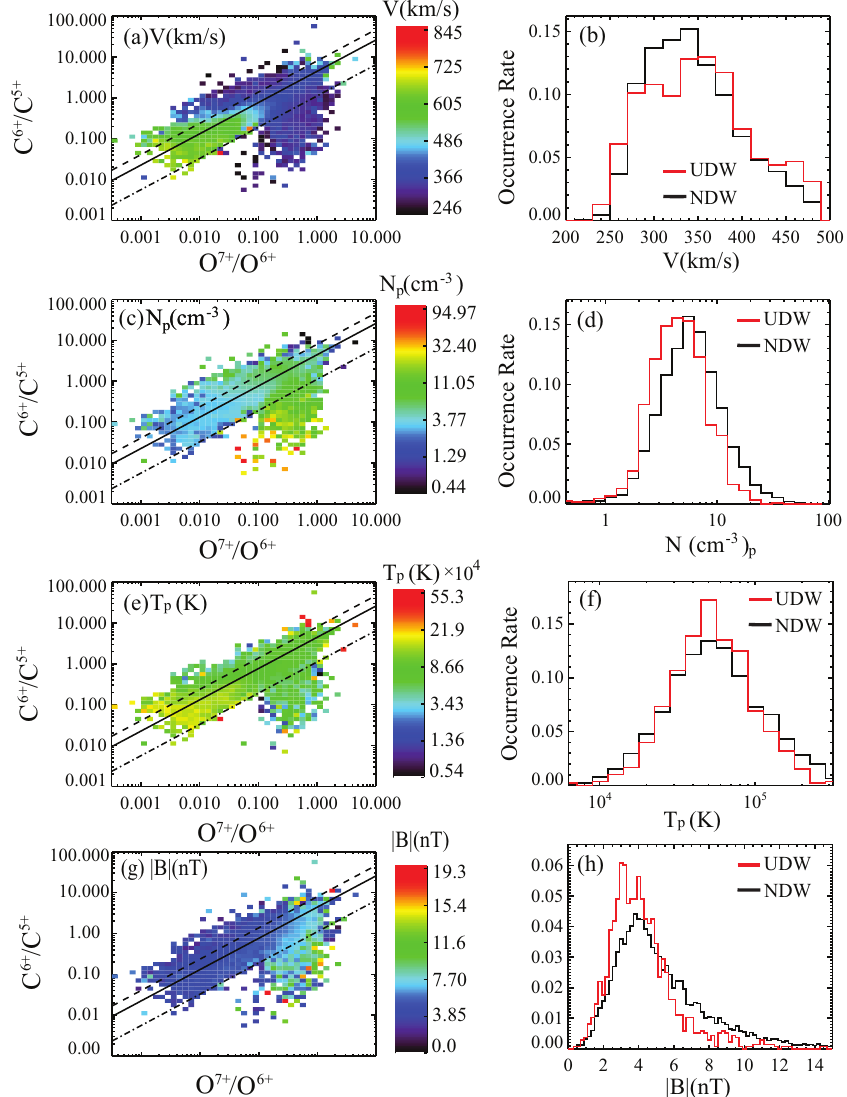
Figure 5. ( Left ) distributions of all non-ICME solar wind (January 1998–August 2011). ( a ) proton speed (V), ( c ) density (N p ), ( e ) temperature (T p ), ( g ) the magnitude of the interplanetary magnetic field ( | B | ), in the log(C 6 + /C 5 + ) and log(O 7 + /O 6 + ) space. The black solid line is the linear fit of the whole solar wind distribution in 2007, the dashdotted black lines are the threshold by which the Outliers are selected (see Zhao [13] for details). The dashed black lines on the upper-boundary of this plot are one of the thresholds we use to select the UDW in this study. ( Right ) histograms of the V ( b ), N p ( d ), T p ( f ), and | B | ( h ) in the UDW (red) and NDW